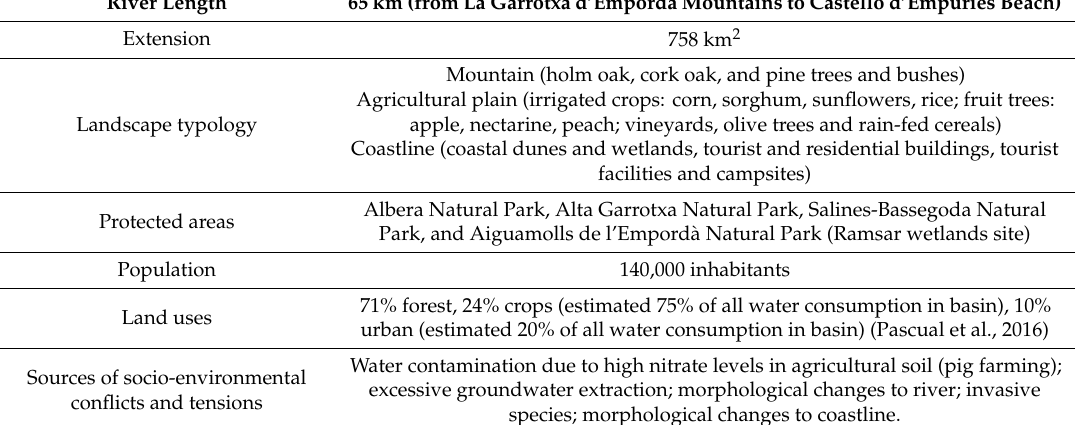
Table 1. Characteristics of the Muga river